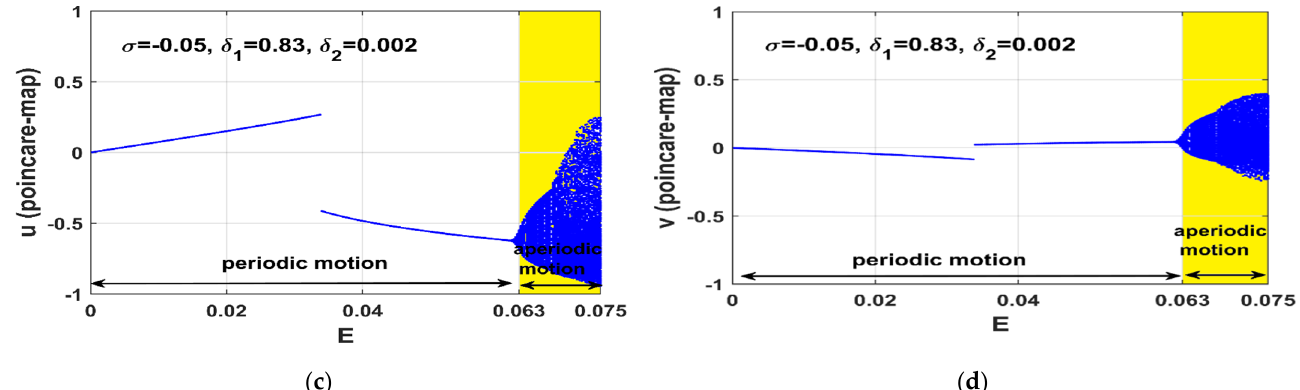
Figure 11. 𝐸 − response curve of the controlled Jeffcott rotor (i.e., 𝛿 (cid:2869) = 0.83 and 𝛿 (cid:2870) = 0.002 ) and Figure 11. E —response curve of the controlled Jeffcott rotor (i.e., δ 1 = 0.83 and δ 2 = 0.002) and the the corresponding bifurcation diagrams at 𝜎 = −0.05 : ( a , b ) oscillation amplitudes ( 𝑎 (cid:2869) and 𝑎 (cid:2870) ) ver- corresponding bifurcation diagrams at σ = − 0.05: ( a , b ) oscillation amplitudes ( a 1 and a 2 ) versus E sus 𝐸 when 𝜎 = 0 , and ( c , d ) Poincaré-map of the instantaneous oscillations 𝑢(𝑡) and 𝑣(𝑡) versus when σ = 0, and ( c , d ) Poincar é -map of the instantaneous oscillations u ( t ) and v ( t ) versus E when 𝐸 when 𝜎 = 0 . σ = 0.